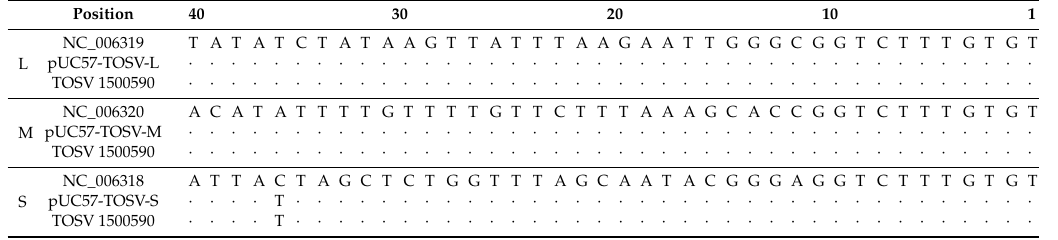
Table A4. Changes were identified in the 3 (cid:48) antigenomic UTRs of TOSV 1500590 when compared with the reference